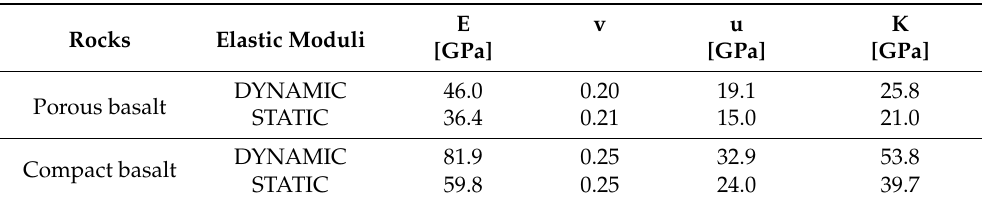
Table 3. Dynamic and static elastic moduli. E—Young moduli, v—Poisson ratio, u—shear moduli, K—bulk moduli.